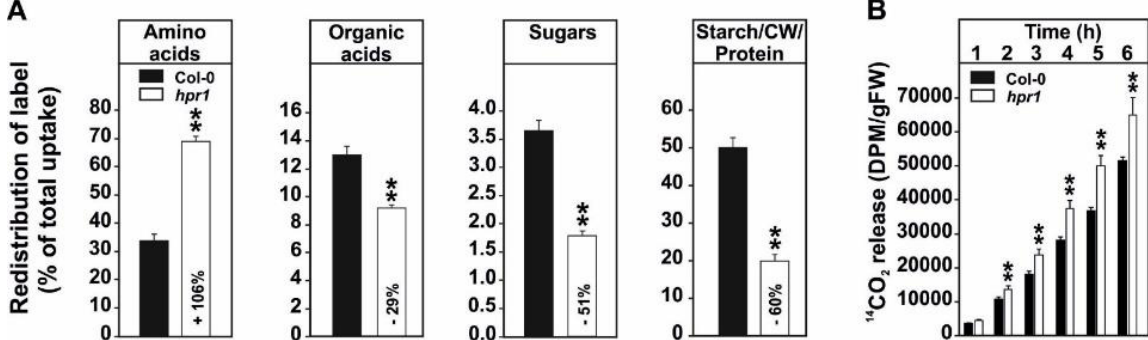
Figure 2. Carbon isotope redistribution following 14 C-glycine-labeling. Shown is ( A ) the redistribution of 14 C in four major fractions of cellular compounds and ( B ) the 14 CO 2 evolved from leaf-discs harvested from the wild type in comparison with the hpr1 mutant. Plants were grown under controlled environmental conditions (390 ppm CO 2 , ~120 µ mol m − 2 s − 1 light intensity, 20/18 ◦ C day/night temperature, ~70% relative humidity) for 5 weeks (12/12 h day/night cycle). At this time point, leaf-discs were fed with [U- 14 C]-glycine for 6 h and then harvested for subsequent analysis. The 14 CO 2 evolved was captured (in hourly intervals) in a KOH trap and the amount of radiolabel released was subsequently quantified. Shown are means ± SD of five biological replicates (5 leaf-discs per plant) and asterisks show significant changes compared with the wild type according to Student’s t -test (** p < 0.01).